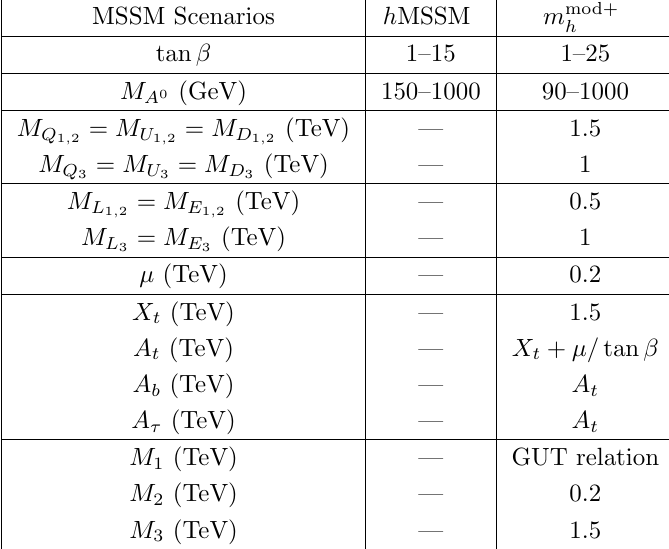
Table 2 . MSSM input parameters for our two MSSM benchmark